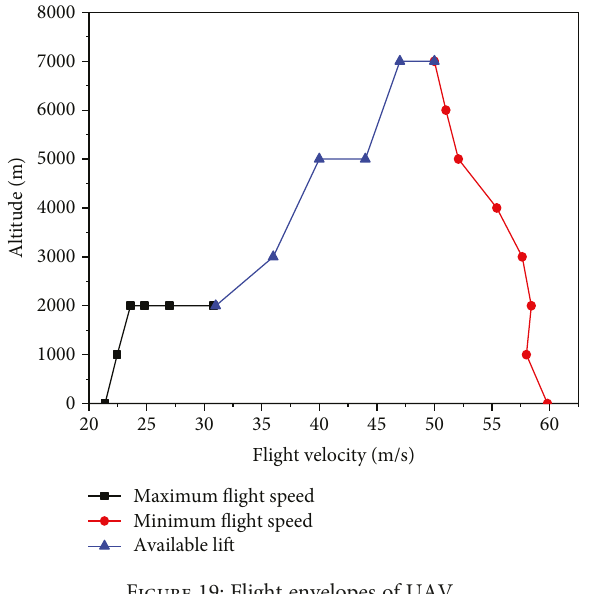
Figure 21: Maximum fl ight distance at di ff erent